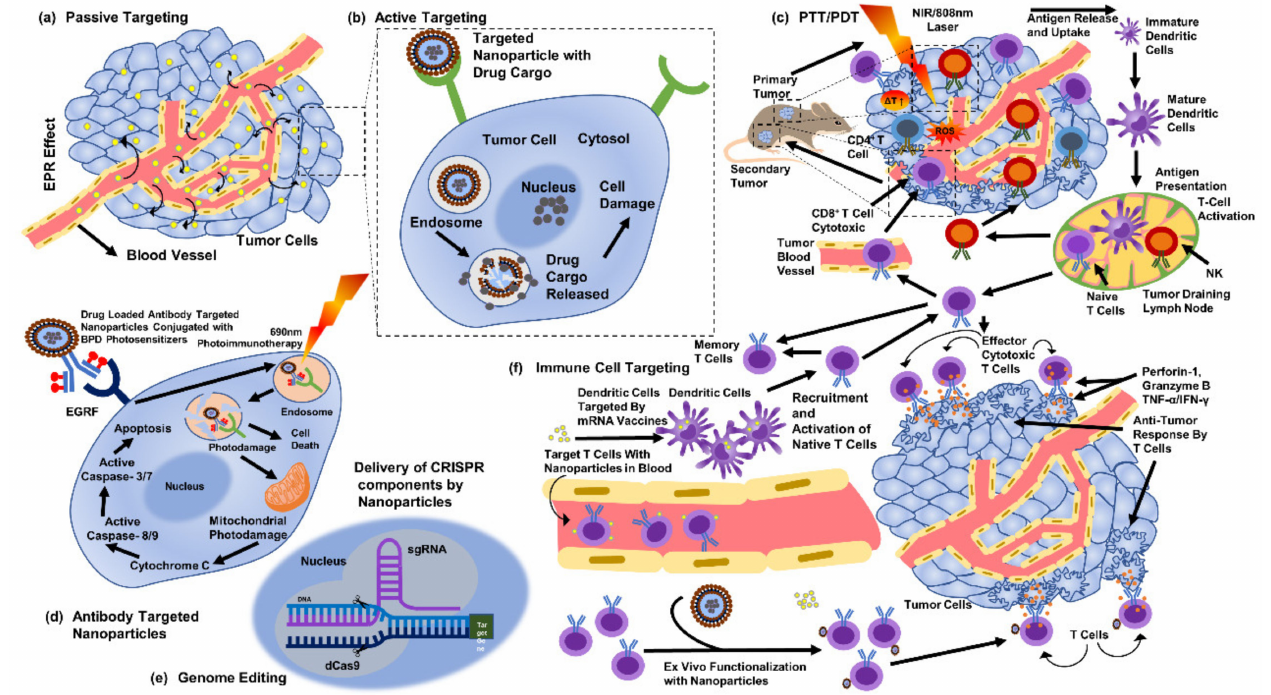
Figure 5. Methods to target cancer cells through silver nanoparticles (part of the figure reproduced with permission from all authors)